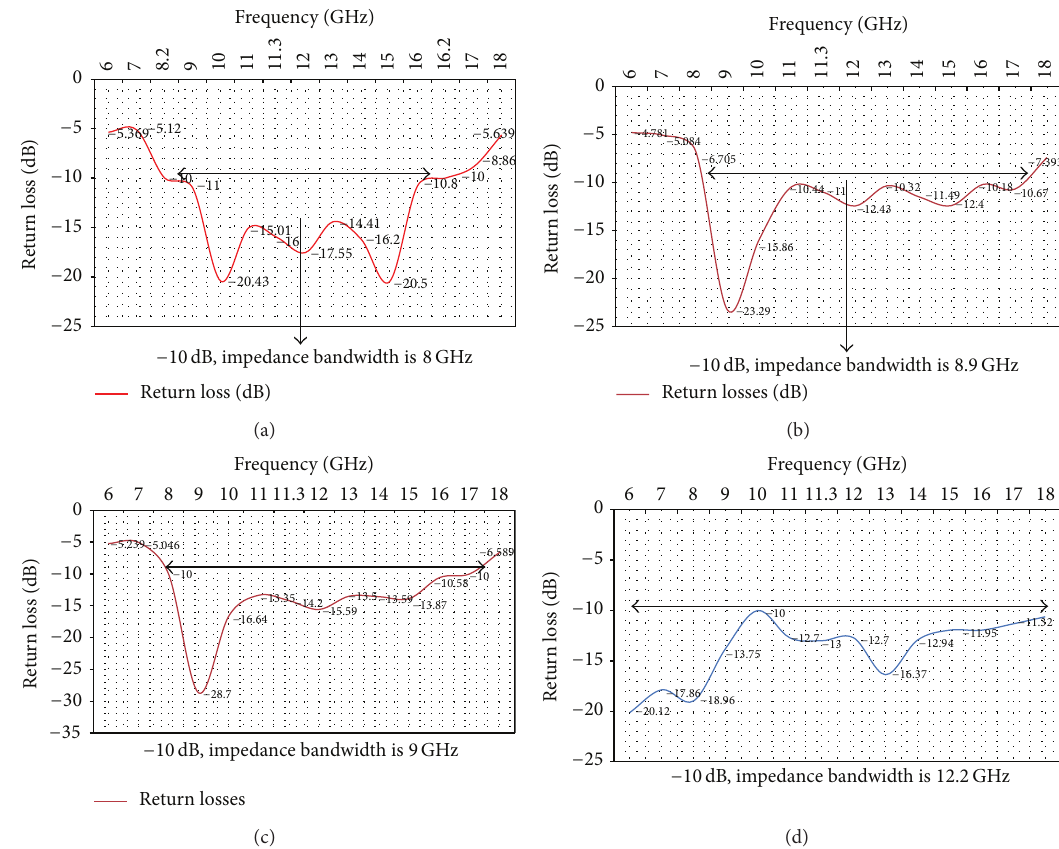
Figure5:(a)Returnlossesversusfrequencyfordimensionofgroundplan11.43 × 13.97mm 2 .(b)Returnlossesversusfrequencyfordimension of ground plan 12.7 × 12.7mm 2 . (c) Return losses versus frequency for dimension of ground plan 12.7 × 13.97 mm 2 . (d) Return losses versus frequency.